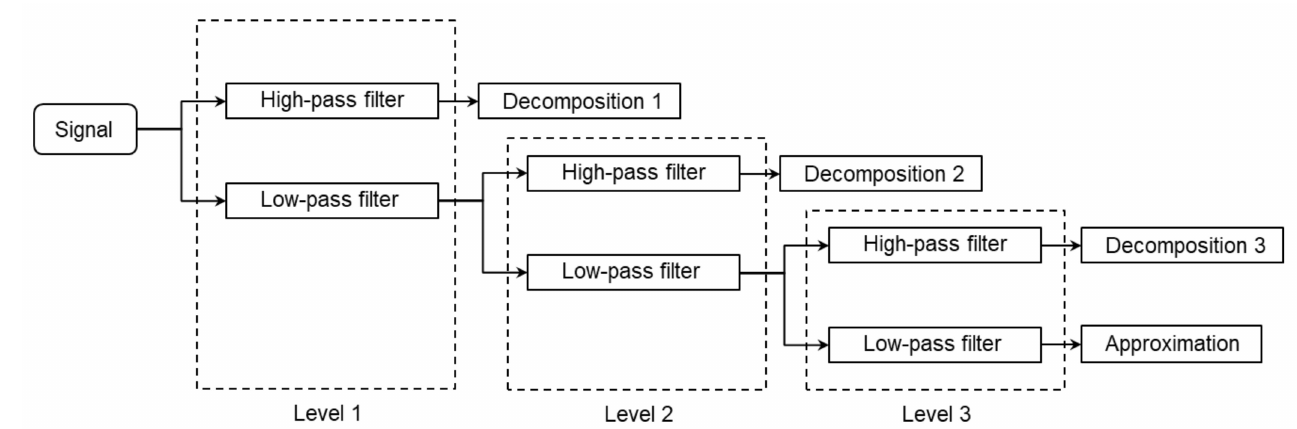
Figure 3. Flowchart for three-level Maximum Overlap Discrete Wavelet